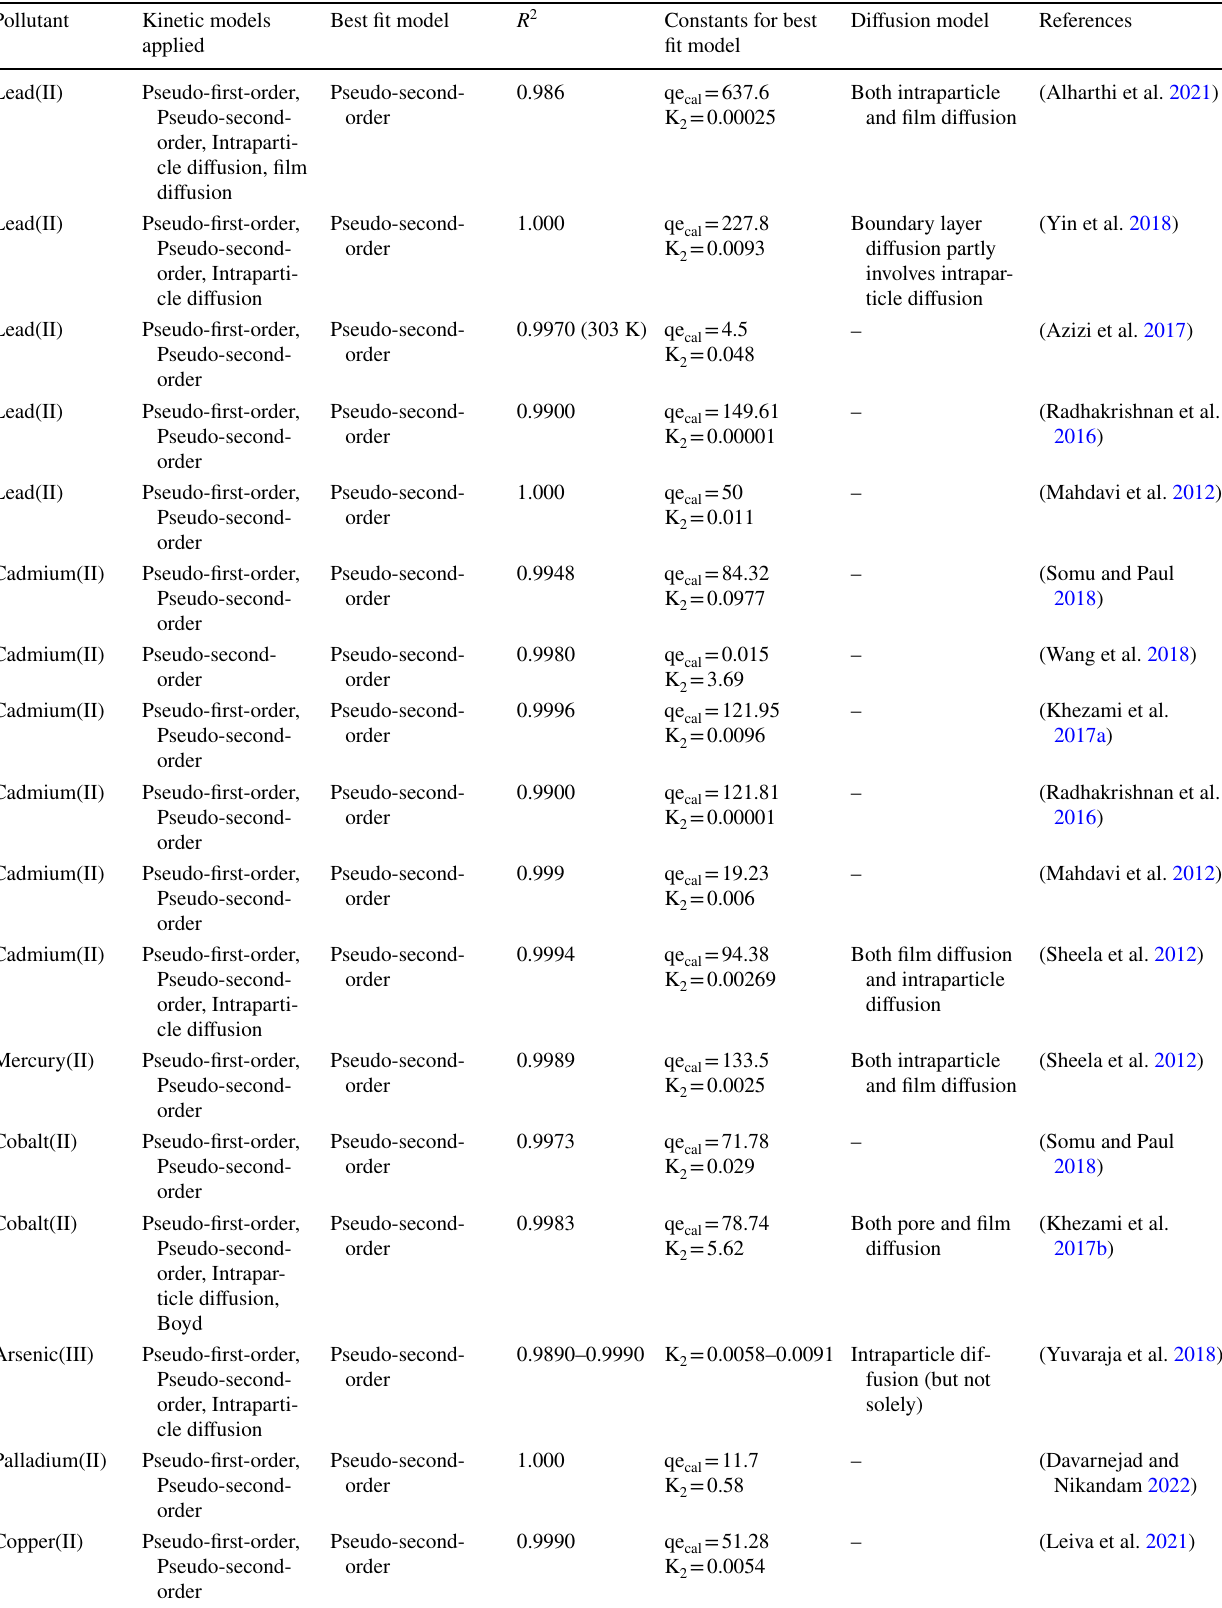
Table 4 The kinetic modeling of heavy metals and radionuclides adsorption onto ZnO nanoparticles